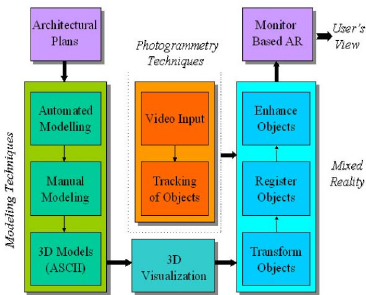
Figure 1. A general view of ARICH system (Mourkoussis et al, 2002).